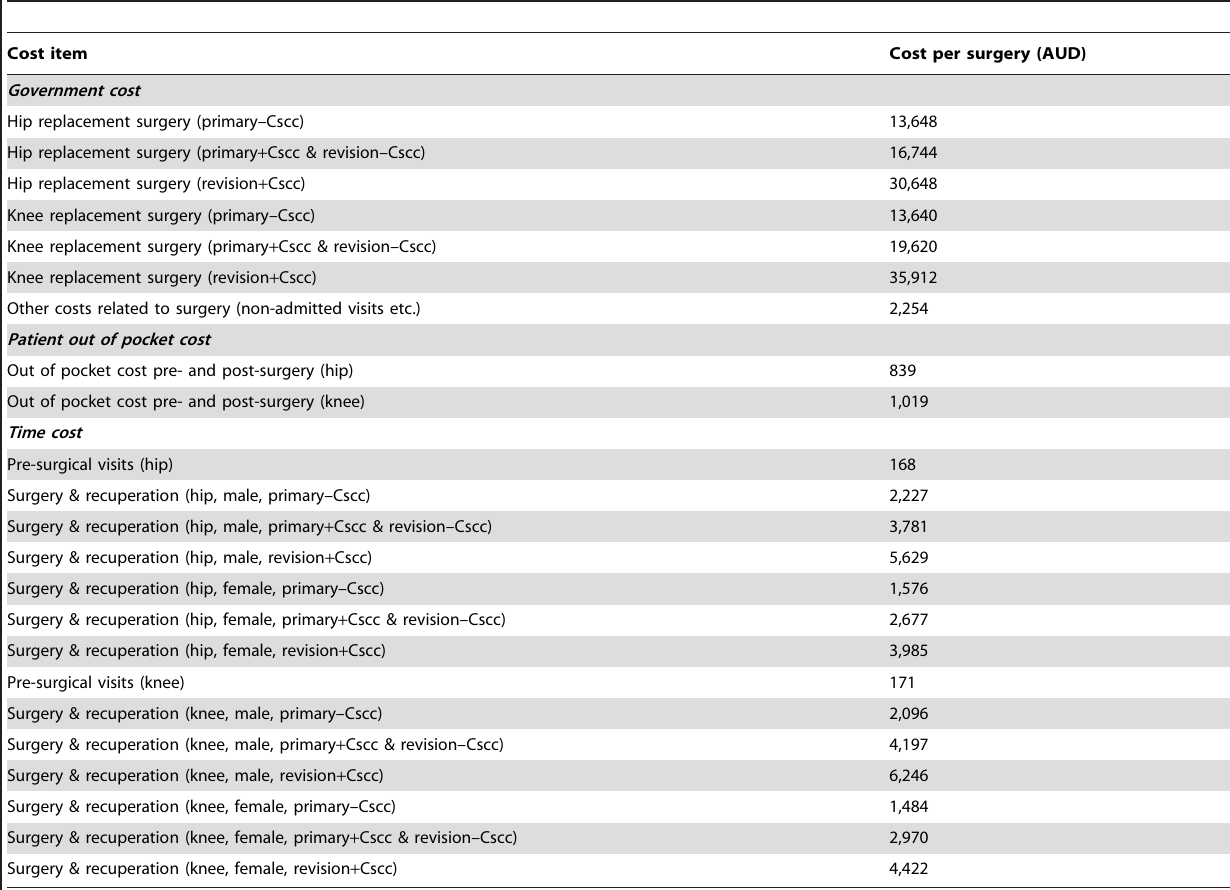
Table 4. Intervention cost (per surgery).